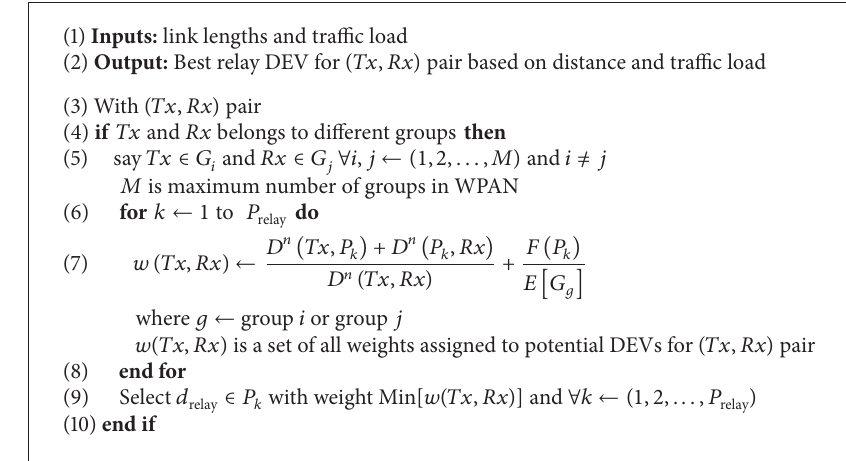
Algorithm 1: Distance based intergroup relay selection.